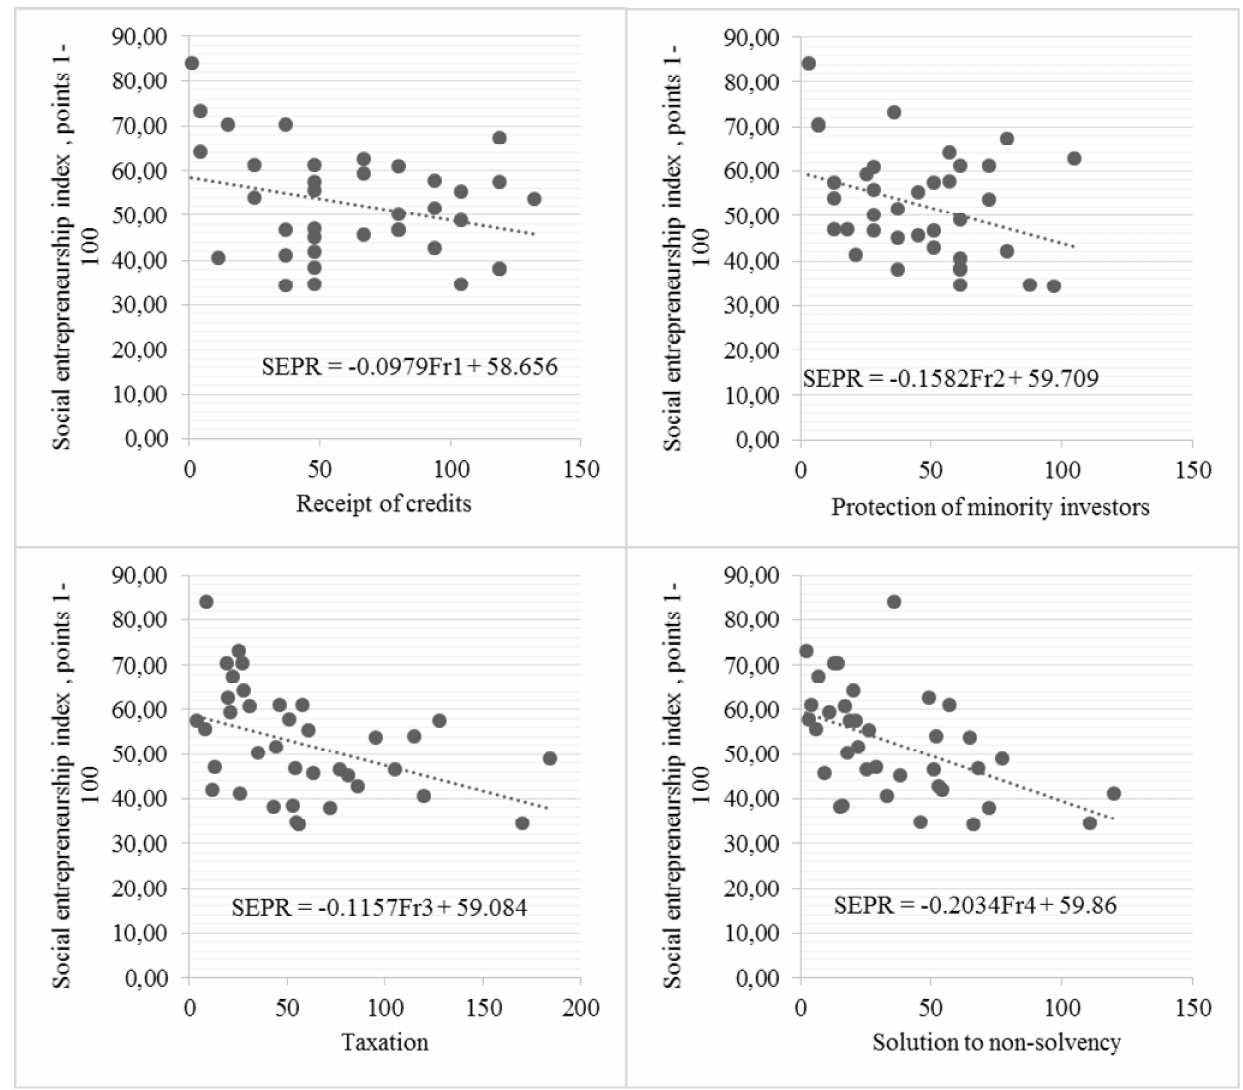
Figure 3. Residual graphs. Source: Obtained by the authors automatically with the help of the “Regression” function in Microsoft Excel.